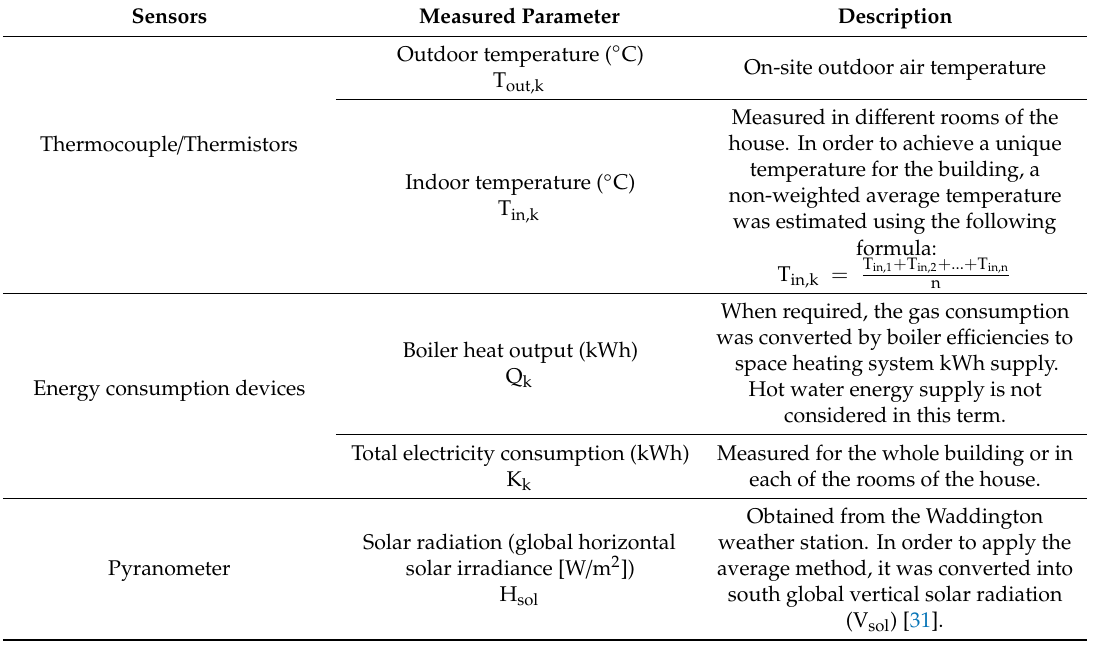
Table 1. List of input parameters for applying the average